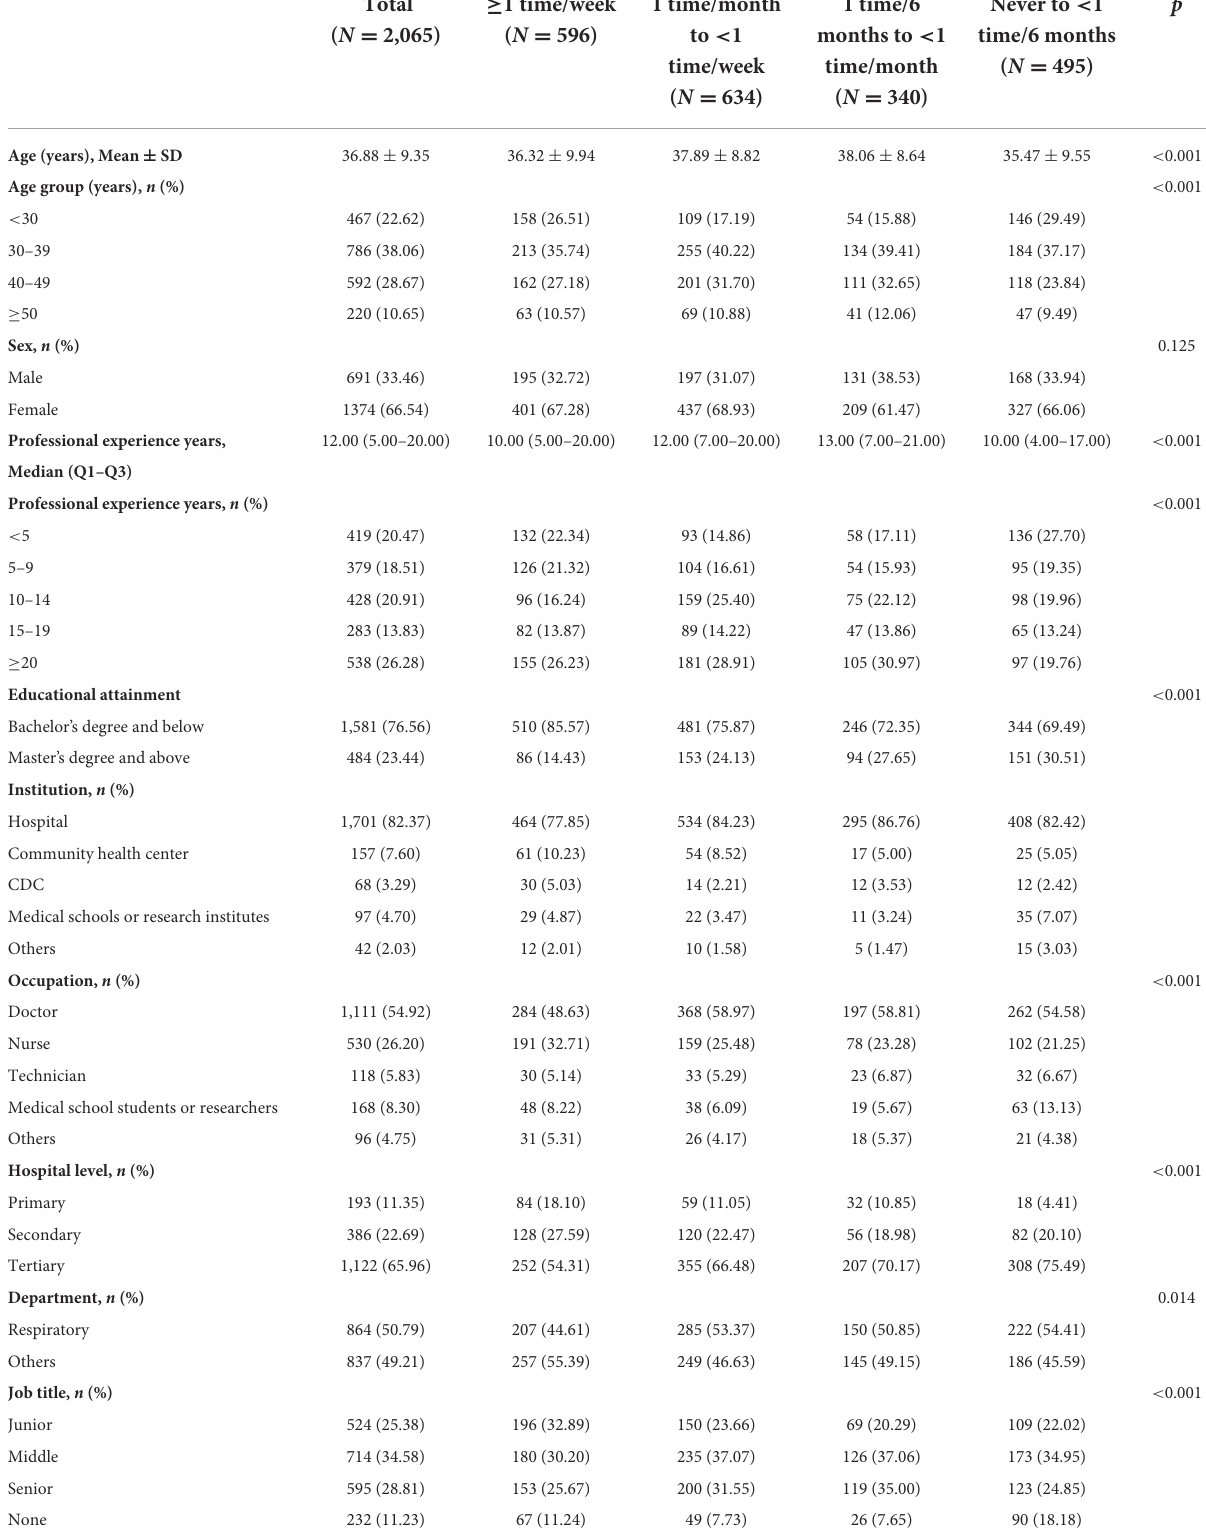
TABLE 1 Characteristics of participants by vaccine-focused SDL